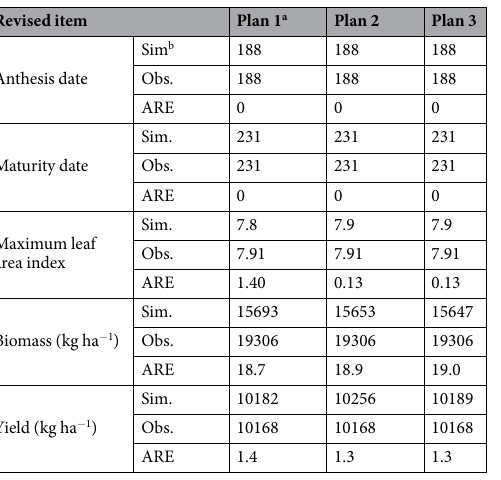
Table 2. Results of calibration and verification of the CERES-Wheat model for winter wheat growth in the 2015–2016 growing season at the Experimental Station located in Xinxiang, Henan Province, China. Notes: a Plan 1 represents the DSSAT modification plan with the original PT model; Plan 2 the original PT model but with a dynamic Kc function; and Plan 3 the calibrated Hargreaves model and a dynamic Kc function. b Sim. and Obs. represent the simulated and observed values, respectively. ARE is absolute relative error, %. And the same below.